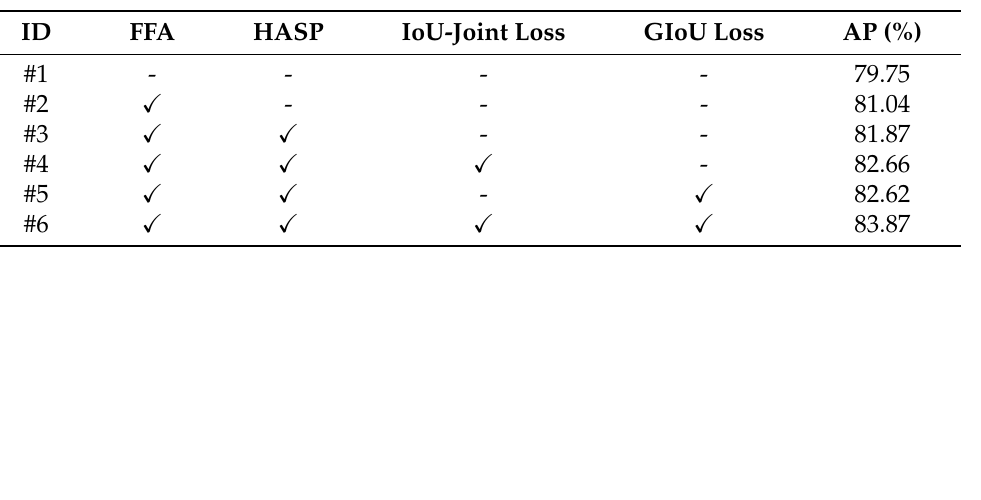
Table 3. Ablation studies on LR-TSDet. We adopted RetinaNet-B as the baseline and applied each module gradually to evaluate the